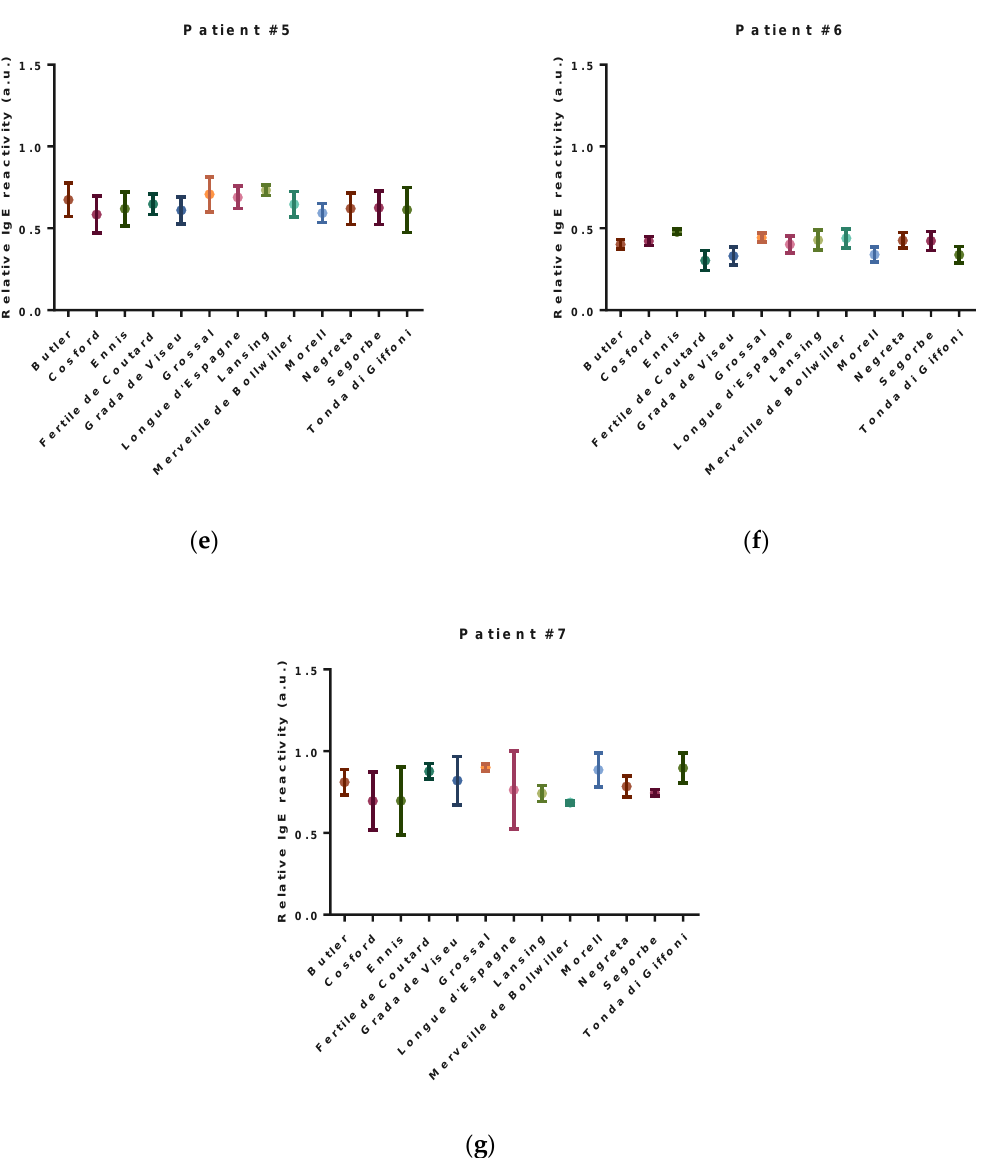
Figure 4. ( a – g ) Relative IgE-reactivity of the di ff erent hazelnut varieties under study using the sera of Figure 4. ( a–g ) Relative IgE-reactivity of the different hazelnut varieties under study using the sera of seven allergic individuals. No significant di ff erences were detected ( p < seven allergic individuals. No significant differences were detected ( p < 0.05).